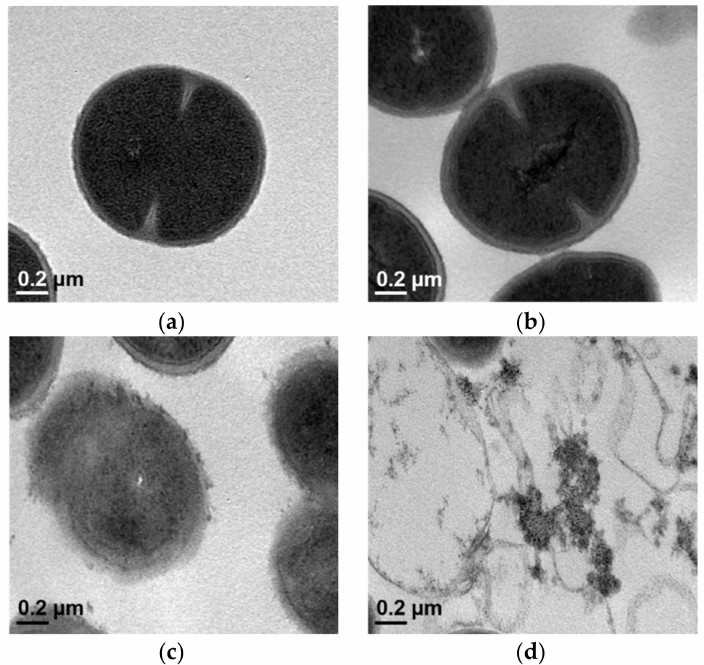
Figure 4. Transmission electron microscopy (TEM) analyses of MRSA DPS-1 after exposure to SKN. ( a ) Untreated control MRSA; ( b ) MRSA treated with 62.5 µ g/mL GEN (1/2 × MIC); ( c ) MRSA treated with 7.8 µ g/mL SKN (1/2 × MIC); ( d ) MRSA treated with 7.8 µ g/mL SKN (1/2 × MIC) and 62.5 µ g/mL GEN (1/2 × MIC).